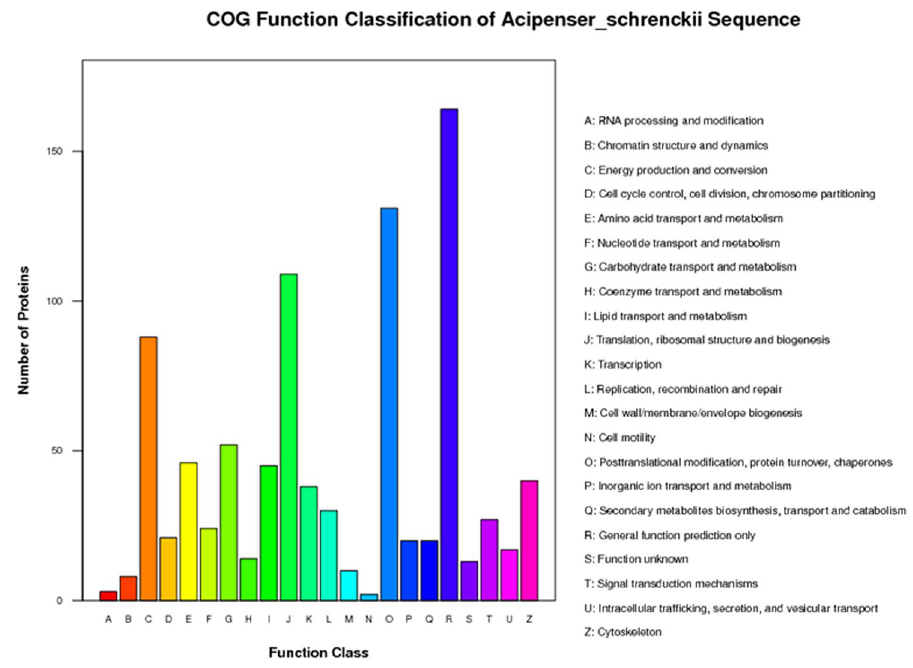
Figure 3. Cluster of orthologous groups (COG) classification of peptides. The peptides were classified functionally into 22 molecular families in the COG